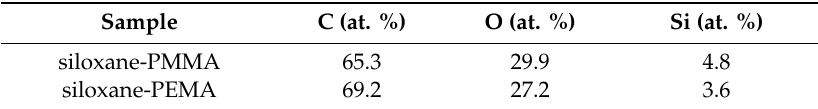
Table 4. Composition [atomic %] deduced from survey XPS spectra recorded for siloxane-PMMA and siloxane-PEMA hybrid sol-gel coatings deposited on AA7075-T6. Please note that carbon content includes also adventitious carbon. Sample C (at. %) O (at. %) Si (at. %) siloxane-PMMA 65.3 29.9 4.8 siloxane-PEMA 69.2 27.2